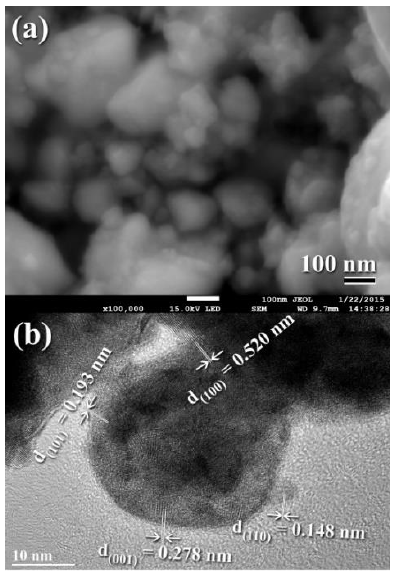
Figure 22. ( a ) FE-SEM, and ( b ) HR-TEM micrographs of mechanically ball milled hcp-WC for 20 h. After 20 h, these fine WC nanopowder particles were mixed with powders containing 7% (10Co/4Cr) and ball milled for a variety of MM times. Figure 21e illustrates the XRD pattern of the first WC/7 wt. % (10Co/4Cr) powders (before ball milling, 0 h). The